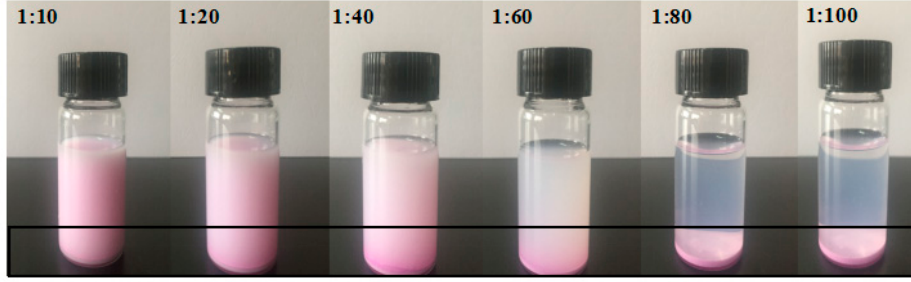
Figure 5. Effect of ratio of emulsifier/core materials on the formation of the OMC microcapsules.